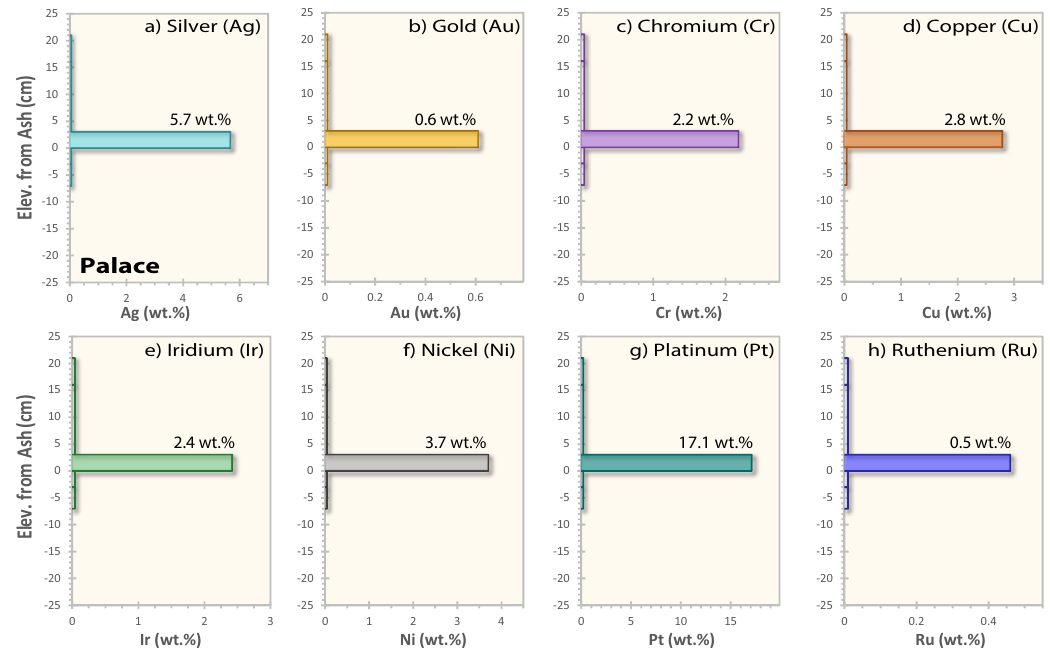
Figure 35. Average composition of selected metal-rich nuggets from the palace. ( a - h ) Silver (Ag), gold (Au), chromium (Cr), copper (Cu), iridium (Ir), nickel (Ni), platinum (Pt), and ruthenium (Ru), showing wt.% in selected nuggets from the destruction layer of the palace